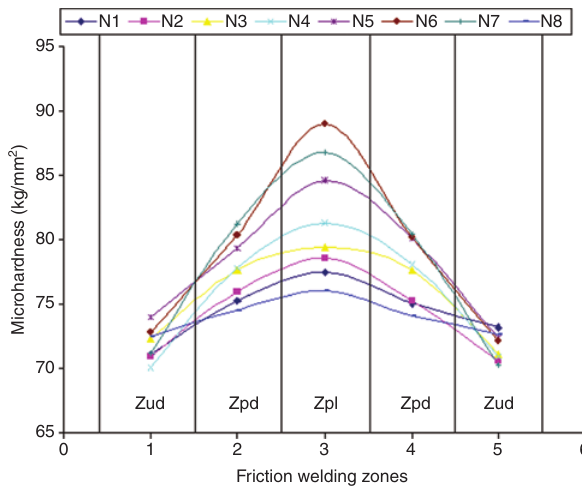
Figure 15 Microhardness images of the samples.